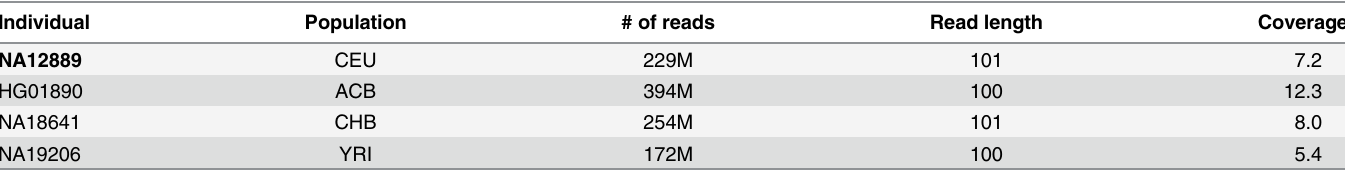
Table 1. Sequence reads information from four human individuals from the 1000 Genomes Project. # of reads: in millions. Coverage: average sequence depth per base.